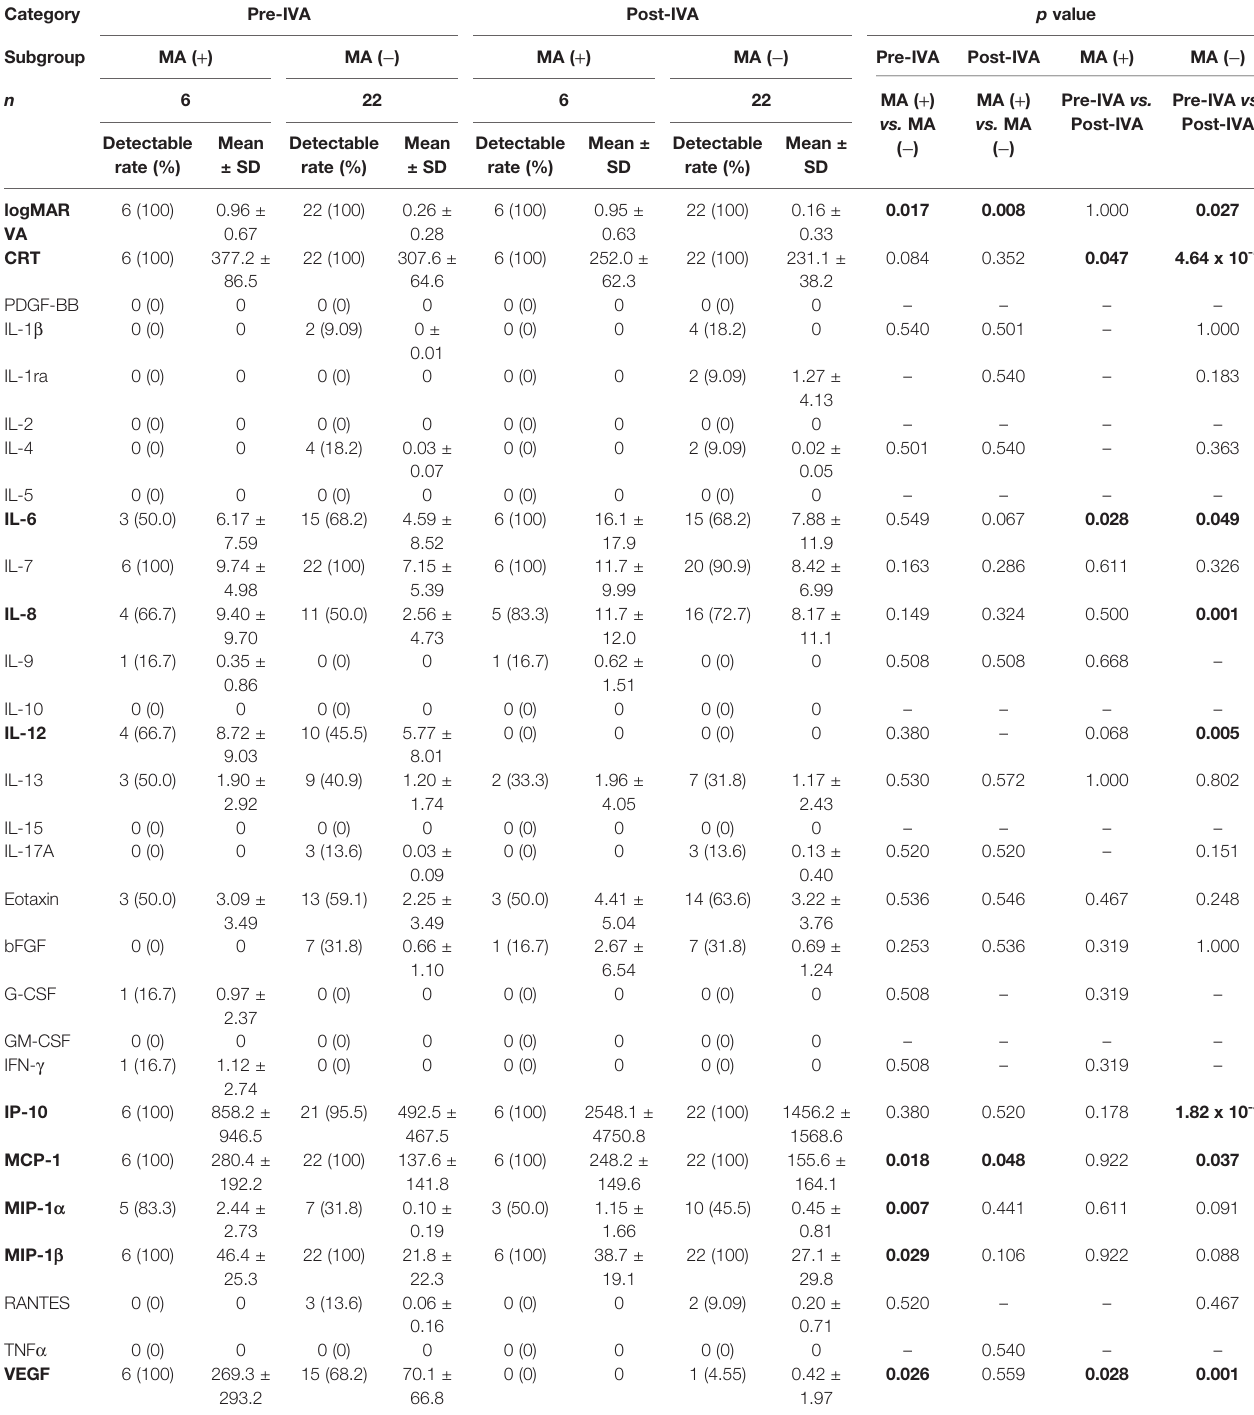
TABLE 2 | Visual acuity, central retinal thickness, and aqueous humor cytokine levels in nAMD patients with or without incidence of macular atrophy under a fl ibercept treatment.